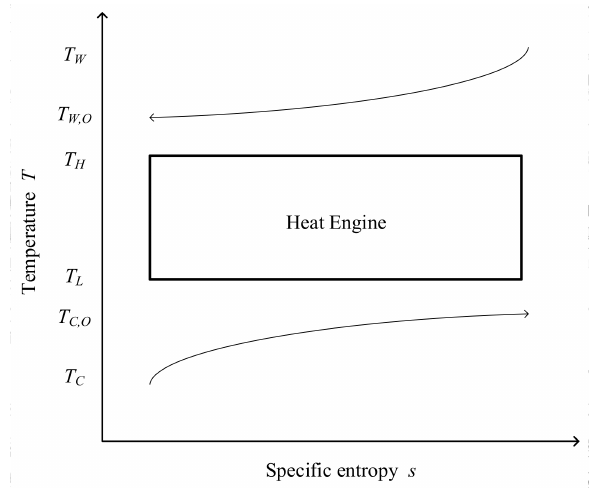
Figure 2. Conceptual T − s diagram of an OTEC power generation system using a reversible heat engine.